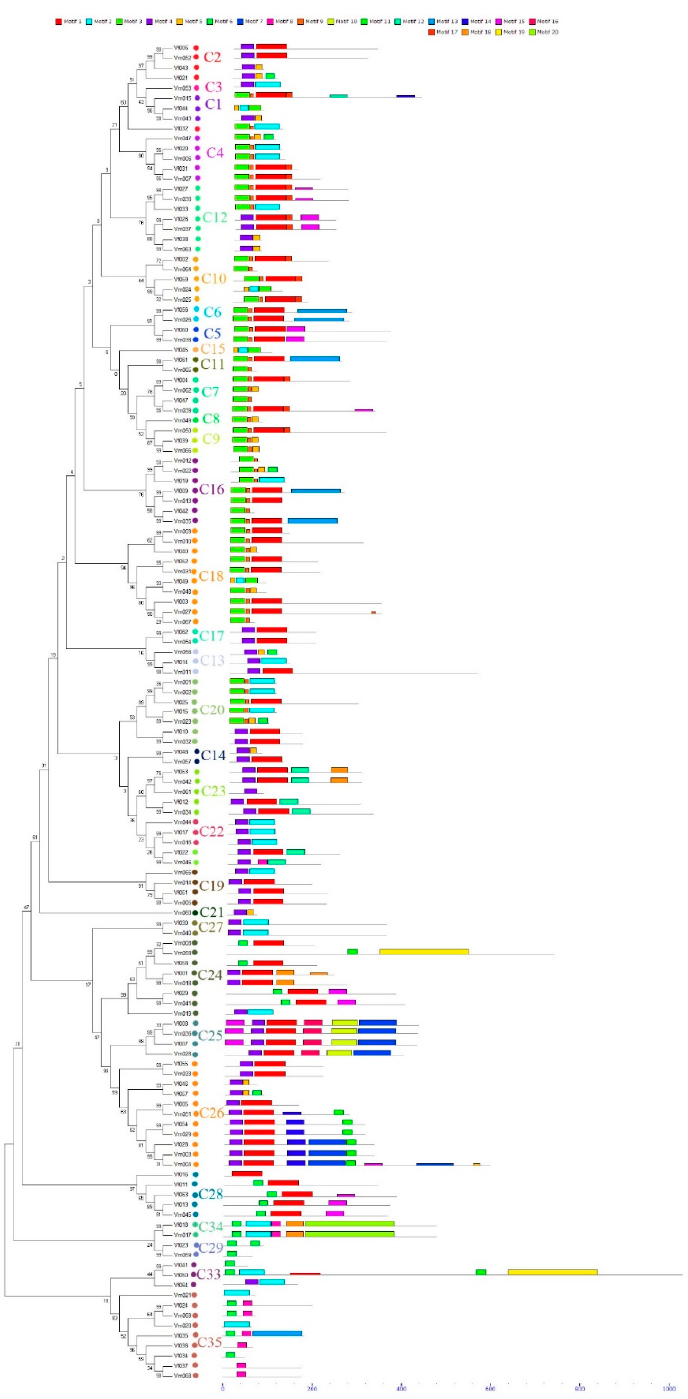
Figure 3. The conserved motifs of MYBs in V. fordii and V. montana . The unrooted phylogenetic tree of 64 VfMYBs and 69 VmMYBs was constructed by MEGA 7.0.7 software with the neighbour-joining (NJ) method and 1000 bootstrap replications. All subgroups named C1 to C35 are marked in different colors. The analysis of conserved motifs was carried out using the MEME online tool, which was set to search for at most twenty motifs with lengths between 6 and 200 amino acids. The colored boxes represent corresponding